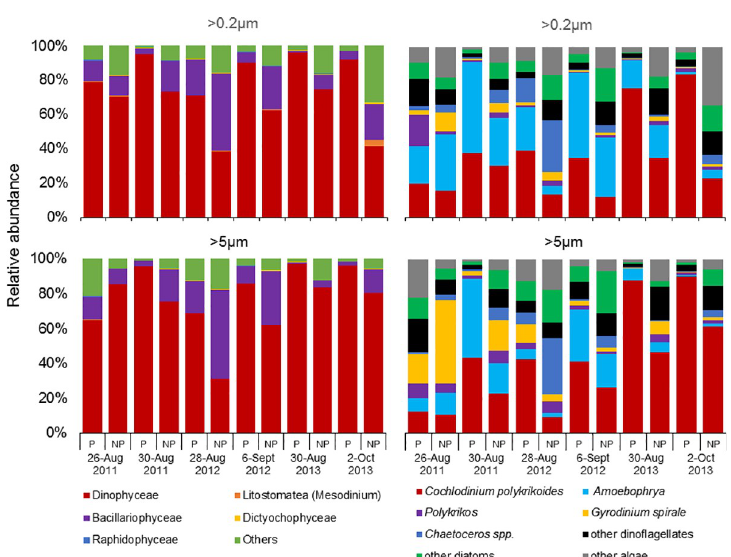
Fig 2. Class- (left panel) and genus/species- (right panel) level relative abundances of algal sequences from size fractionated ( > 0.2 and > 5 micron) samples collected within and immediately adjacent ( < 10m) to the Cochlodinium bloom patches, designated ‘patch’ (P) and ‘non-patch’ (NP) samples, respectively, for years 2011, 2012 and 2013. https://doi.org/10.1371/journal.pone.0223067.g002 While patch and non-patch samples were similar there were vast differences between size fractions. Proteobacteria was the dominant phyla followed by Bacteroidetes contributing 60 ± 4% (mean ± SD) and 16 ± 2% of bacterial sequences for the > 0.2 μ m fraction, and 30 ± 8% and 23 ± 7% for the > 5 μ m size fraction, respectively (Fig 5). The SAR11 clade (28 ± 4%) and Flavobacteriales (14 ± 2%) dominated bacterial sequences in > 0.2 μ m fraction,